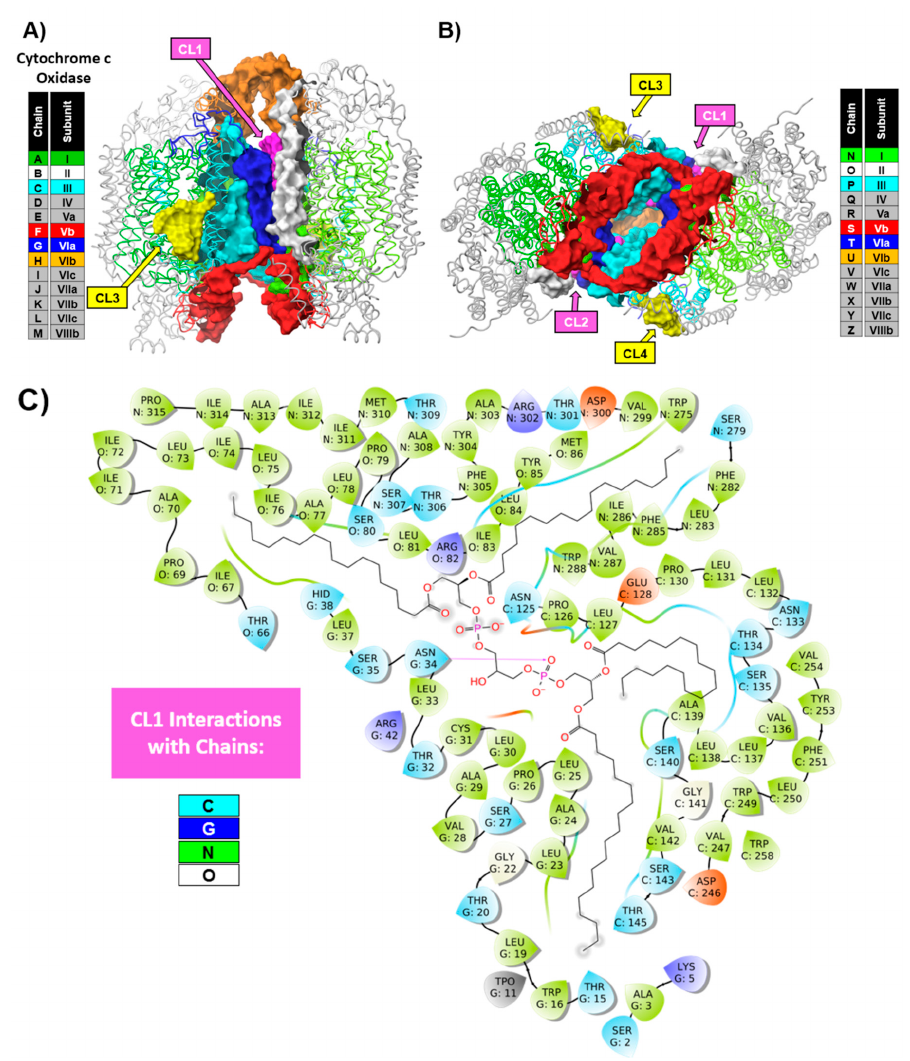
Figure 1. Colored ribbon representations and interface surface of cytochrome c oxidase (CcO; Protein Data Bank (PDB) structure 5B1A [12]). ( A ) Side and ( B ) bottom views. The color coding for the ribbons and subunit interface surfaces is as described in the inset boxes. The surface color coding matches the chains; the surfaces of cardiolipins CL1 and CL2 are colored in violet. In addition, the surfaces of CL3 and CL4 are highlighted in yellow. The other molecules present in the intersubunit cavity are not shown. ( C ) A schematic representation of the amino acids that interact with CL1 and CL2 residues present in the cavity between monomers as determined by the Maestro (Schrodinger Inc., New York, NY, USA) calculation of the interaction profiles. Note that, due to the symmetrical structure of CcO, the interaction of CL2 with chains of both monomeric CcOs is not depicted. The amino-acid color coding for the interaction profile is as follows: green—hydrophobic, light blue—polar; dark blue—charged (positive); orange—charged (negative); gray—unspecified residue or metal. Hydrogen bonds are highlighted with violet arrows.